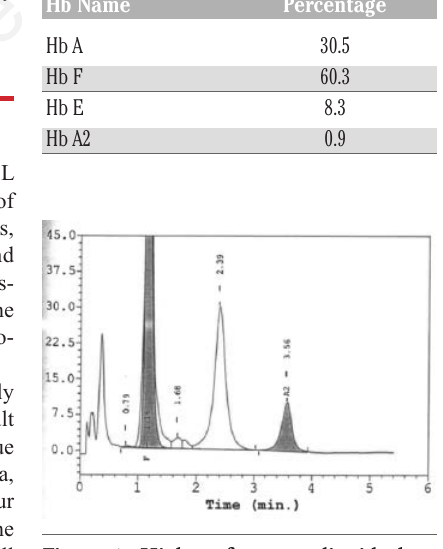
Figure 1. High-performance liquid chro- matography